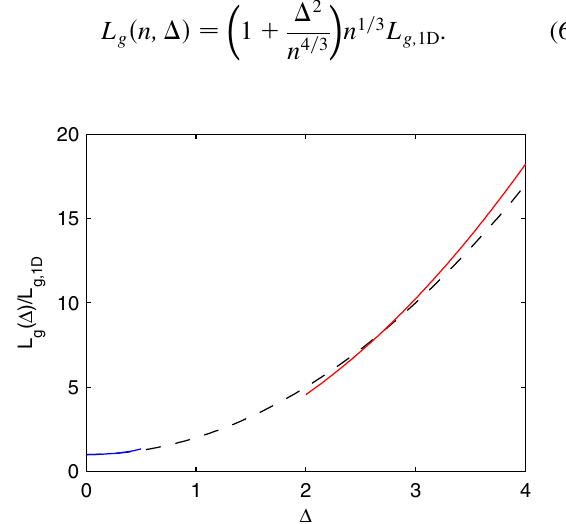
ð (cid:2) Þ =L as g g; 1D = ð (cid:4)(cid:5) FEL Þ (cid:4)